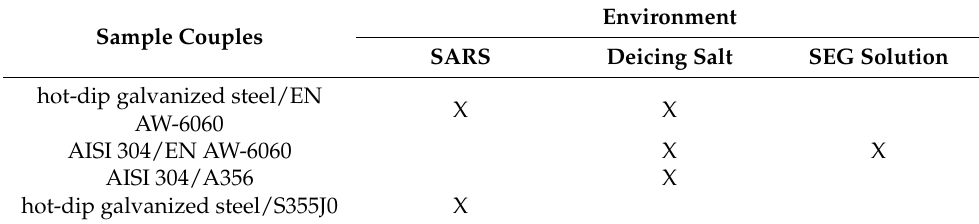
Table 4. Couples of materials in model environments